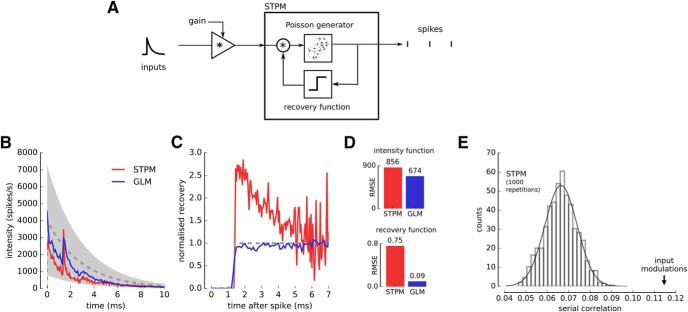
Input modulation may explain deviations of spike train statistics from the STPM and GLM. A, The STPM was extended by including a multiplicative gain factor, which acts on the input function. The gain factor was randomly selected from a uniform distribution [0.2, 1.8] in each trial. The model was simulated with an exponentially decaying intensity function (B, dashed line); maximum amplitude, 4000 spikes/s, time constant, 3 ms; and a step recovery function (C, dashed line); refractory period, 1.4 ms. B, Intensity function of the STPM (red) and GLM (blue) fitted to the simulated spike trains. The intensity function manifests deviations from the real intensity function used in the simulation (dashed line; gray-shaded area corresponds to the amplitude range of intensity function taking into account the gain factor). C, Recovery function of the STPM (red) and GLM (blue) fitted to the simulated spike trains. The STPM-estimated recovery function displays a characteristic overshoot soon after end of the absolute refractory period (1.4 ms; dashed line, real recovery function underlying the spike trains). D, RMS error of the intensity and recovery functions estimated with the STPM and GLM. E, The serial correlation of the model with gain modulation (arrow) is significantly larger (p < 0.01) than predicted in absence of modulation (bar plot, histogram of 1000 serial correlation coefficient obtained from Monte Carlo simulations of the STPM with the intensity and recovery functions shown in B, C, red line).